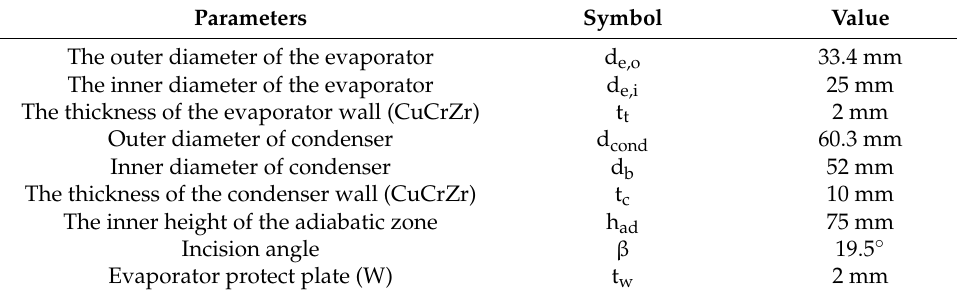
Table 3. Parameters of HPEE body.